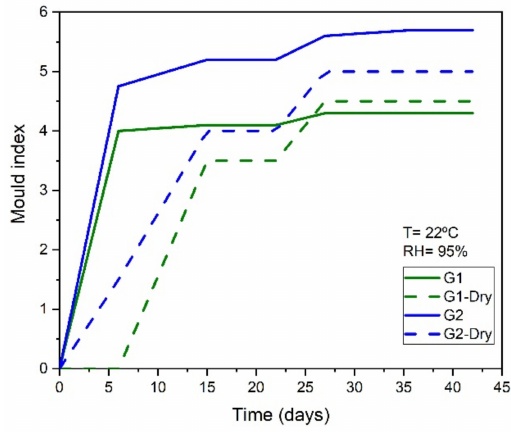
Figure 13. The mould index of the reed as a function of the test